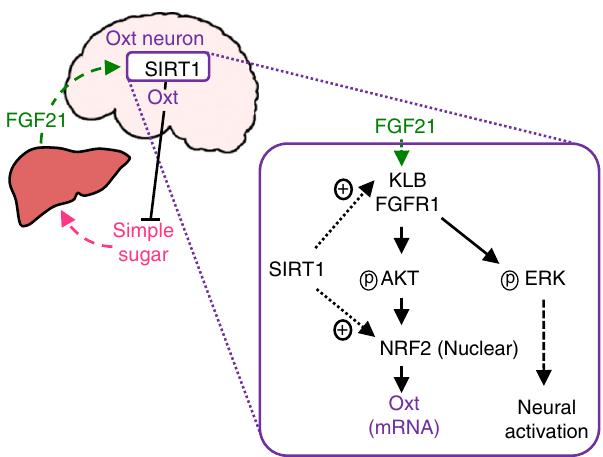
Fig. 10 Proposed model of simple sugar preference regulation by neuronal SIRT1. Ingestion of simple sugar promotes secretion of FGF21 from the liver. The hepatokine FGF21 acts as an endocrine signal to Oxt neurons and promotes Oxt transcription (AKT signalling) and neuronal activation (ERK signalling). Oxt suppresses simple sugar preference by acting on